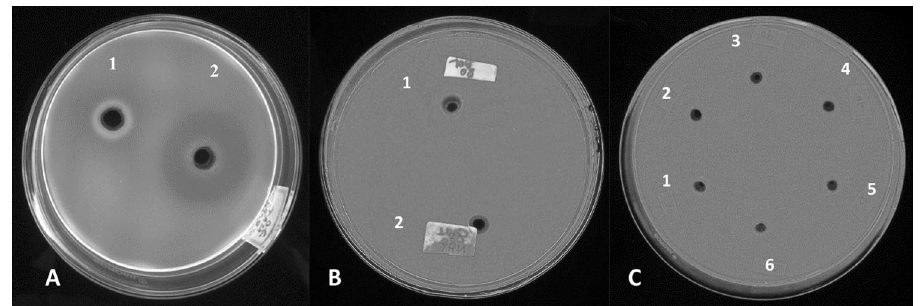
Figure 2. Demonstration of selectivity and reliability of laminarin plate assay. ( A ) 90% saturation ammonium sulfate (AS) precipitate heat treated for 20 min in a boiling water bath (1); 90% saturation AS precipitate non-heat treated (2). ( B ) Heat treated (1) and non-heat treated (2) 90% saturation AS precipitate in a 0.5% carboxymethyl cellulose (CMC) agarose plate. ( C ) Precipitates from various treatment groups (40%-90% AS) tested in a 0.5% CMC agarose plate. 40% (1); 50% (2); 60% (3); 70% (4); 80% (5) and 90% (6). Staining protocol and other parameters for CMC plate assay were same as the laminarin plate assay.